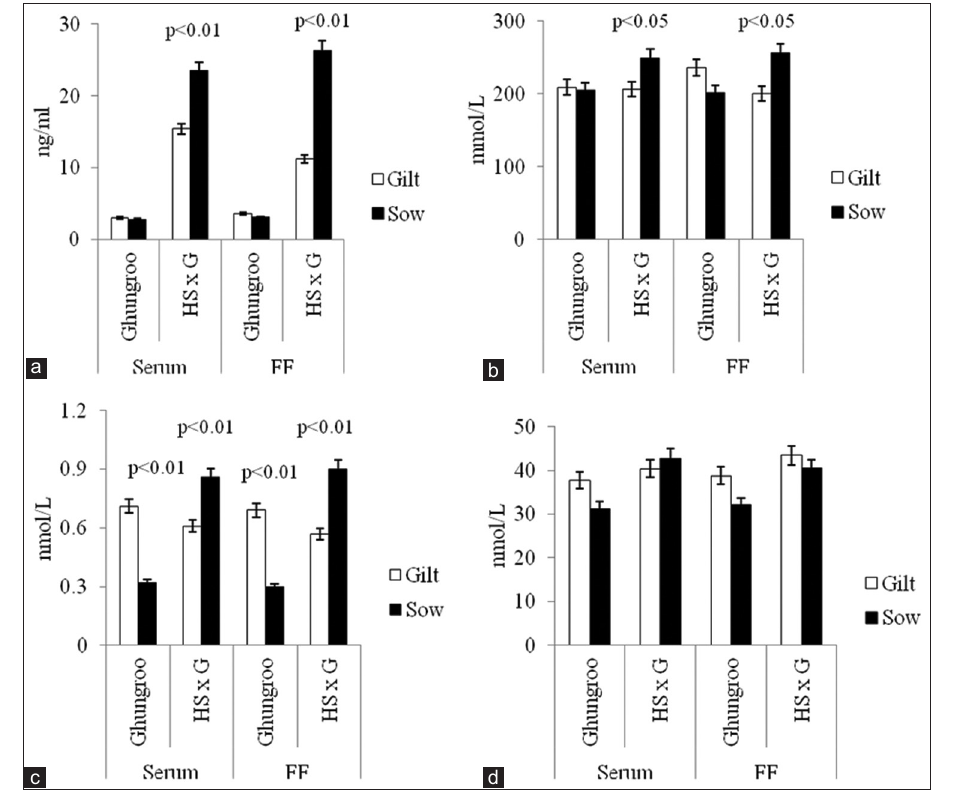
Figure-1: Comparison of metabolic and steroid hormones in serum and follicular fluid (FF) of different genetic groups of pigs based on stage of reproductive life (gilt and sow), (a) testosterone profile, (b) cortisol profile, (c) T3 profile, (d) T4